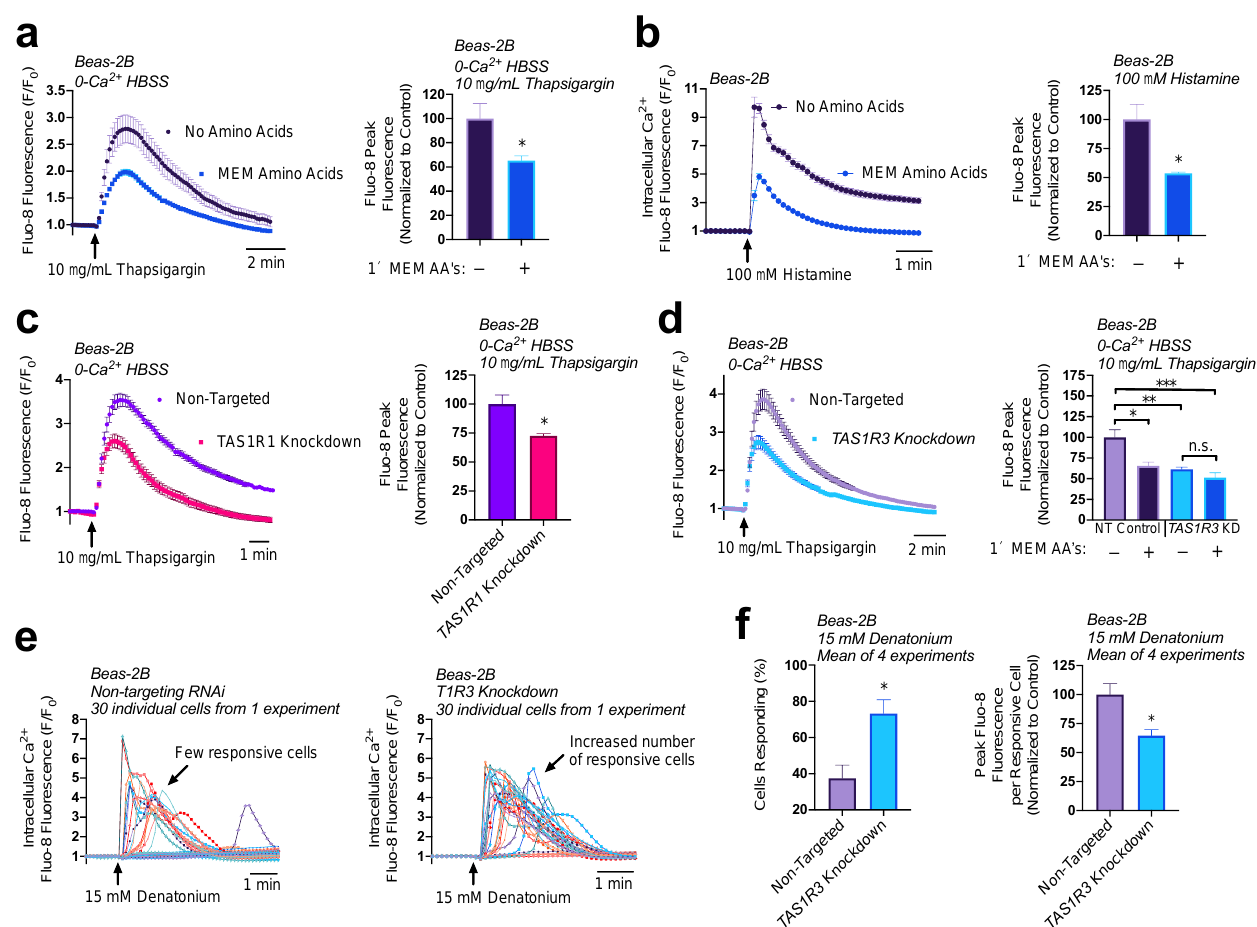
Figure 3. Both T1R1/3 and amino acids impact ER Ca 2+ content and release. ( a ) Beas-2Bs treated with SERCA-pump inhibitor thapsigargin contain ~40% reduced ER Ca 2+ content when in the presence of 1× MEM amino acids relative to untreated controls. ( b ) Addition of 1× MEM AA to Beas-2Bs decreased peak Ca 2+ release via 100 µM histamine treatment by 50%. ( c ) Beas-2Bs with knocked-down T1R1 contained 25% reduced ER Ca 2+ content relative to non-targeting RNAi controls. ( d ) T1R3 knockdown cultures had 30% reduced ER Ca 2+ content relative to non-targeting controls, an effect that was not further altered by amino acid treatment. ( e ) Knocking down T1R3 in Beas-2Bs led to an increase in the number of cells responsive to denatonium. ( f ) Quantifying the results from ( e ), knocking down T1R3 caused a doubling of the number of cells responsive to denatonium, while causing a 35% decrease in Ca 2+ release per responsive cell. Traces are representative of ≥3 experi- ments. Bar graphs containing only two comparison groups were analyzed via t -test; bar graphs con- taining ≥3 groups were analyzed via ANOVA using Bonferroni’s posttest; * p < 0.05, ** p < 0.01, *** p < 0.001, “ n.s. ” represents no significance.